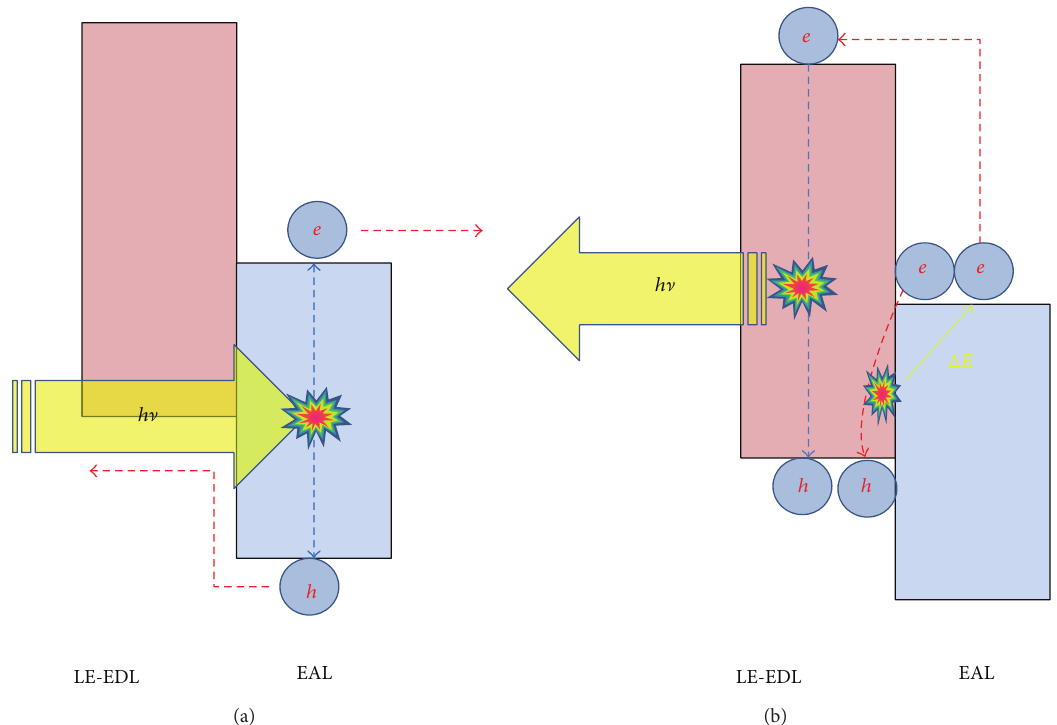
Figure 1: Schematic diagram showing the operation of a PVOLED with a half-gap junction structure: (a) electricity-generation mode and (b) light-emission mode.